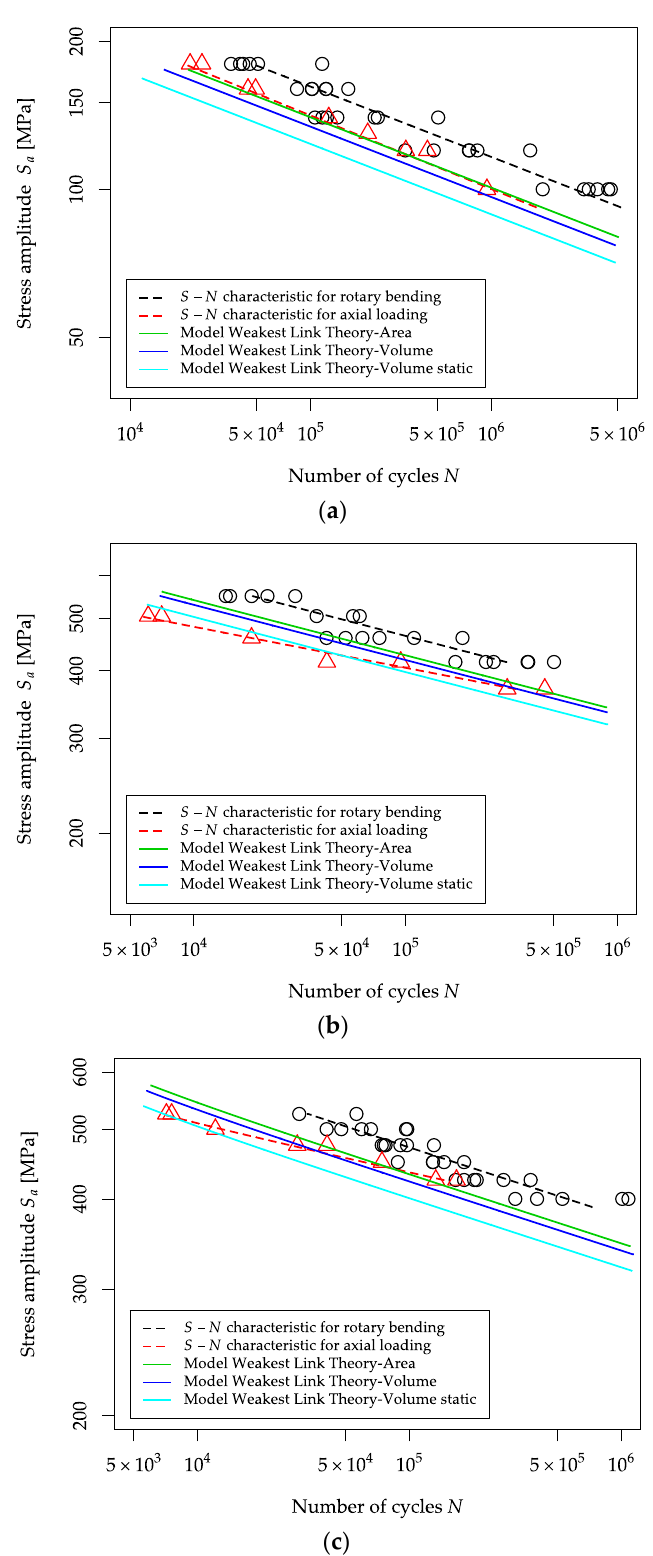
Figure 7. Fatigue characteristic determined based on experimental tests and analytical models for: ( a ) AW 6063 T6, ( b ) S355J2+C, ( c ) 1.4301.